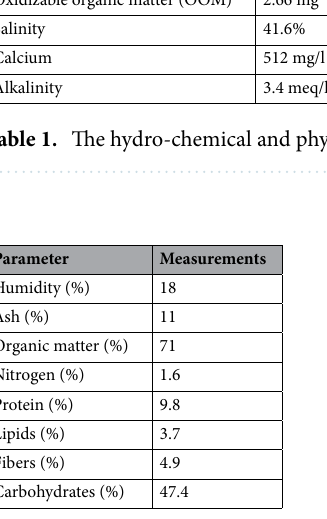
Table 2. Biochemical composition of O. dentata